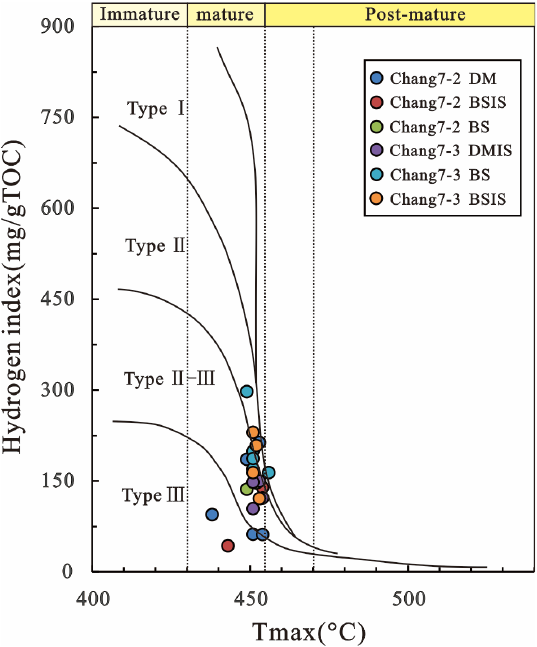
Figure 3. The cross-plot of generative potential (S 1 + S 2 ) and TOC. DM—dark mudstones; BS—black shales; BSIS—black shales interbedded with sandstones; DMIS—dark mudstones in- terbedded with sandstones.